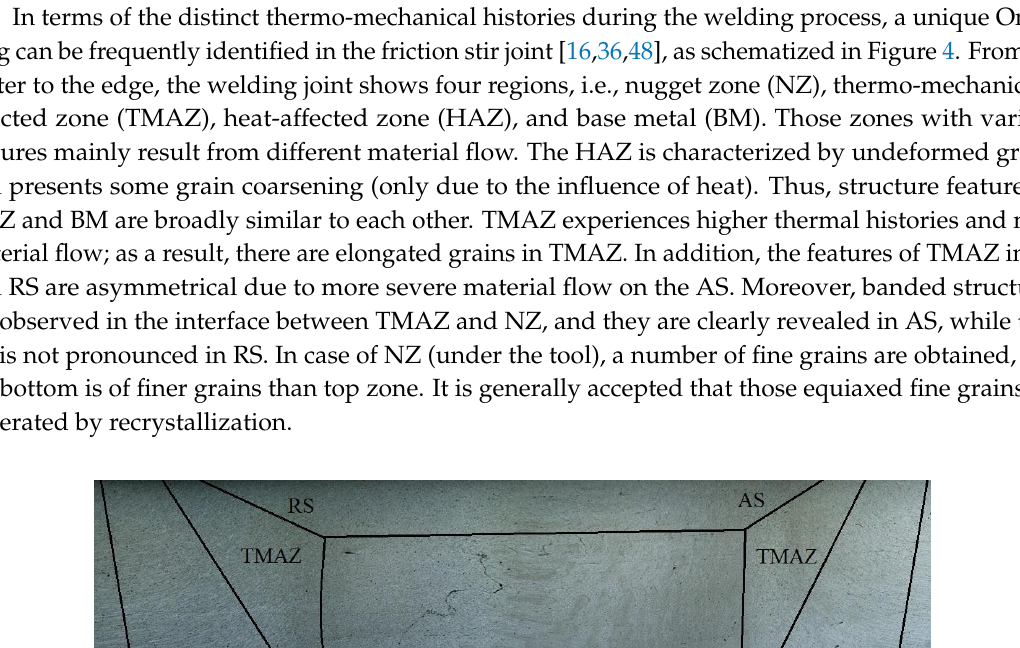
Figure 3. Relationship between the macro-defects and the welding parameters.